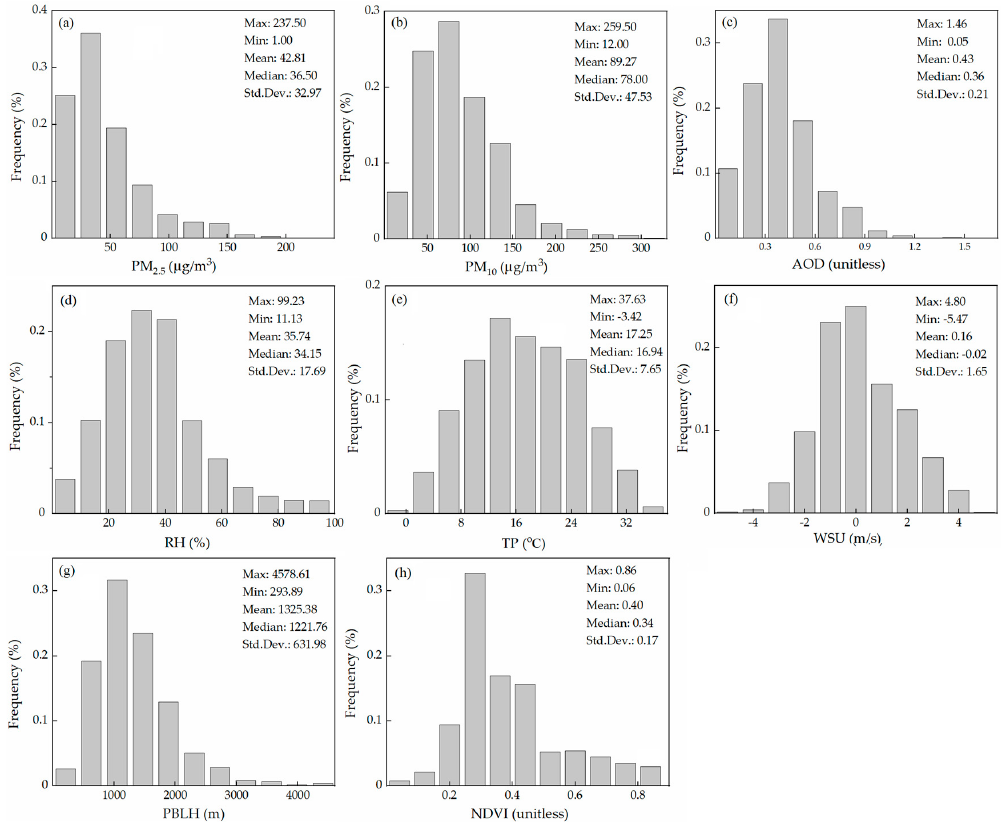
Figure 6. Histograms of dependent and independent variables for PM 2.5 ( a ), PM 10 ( b ), AOD ( c ), RH ( d ), TP ( e ), WSU ( f ), PBLH ( g ) and NDVI ( h ) included in the data set used for model fitting. Statistics in the upper right corner indicate the maximum (Max), minimum (Min), mean, median and standard deviation (Std.Dev.).